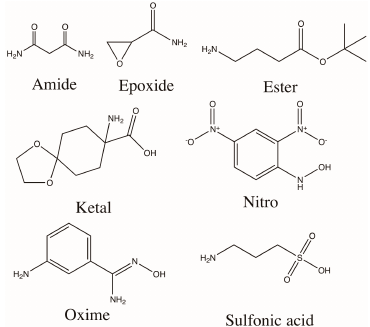
Figure 1. Chemical structures of the molecules used in the modification of medium viscosity alginate.